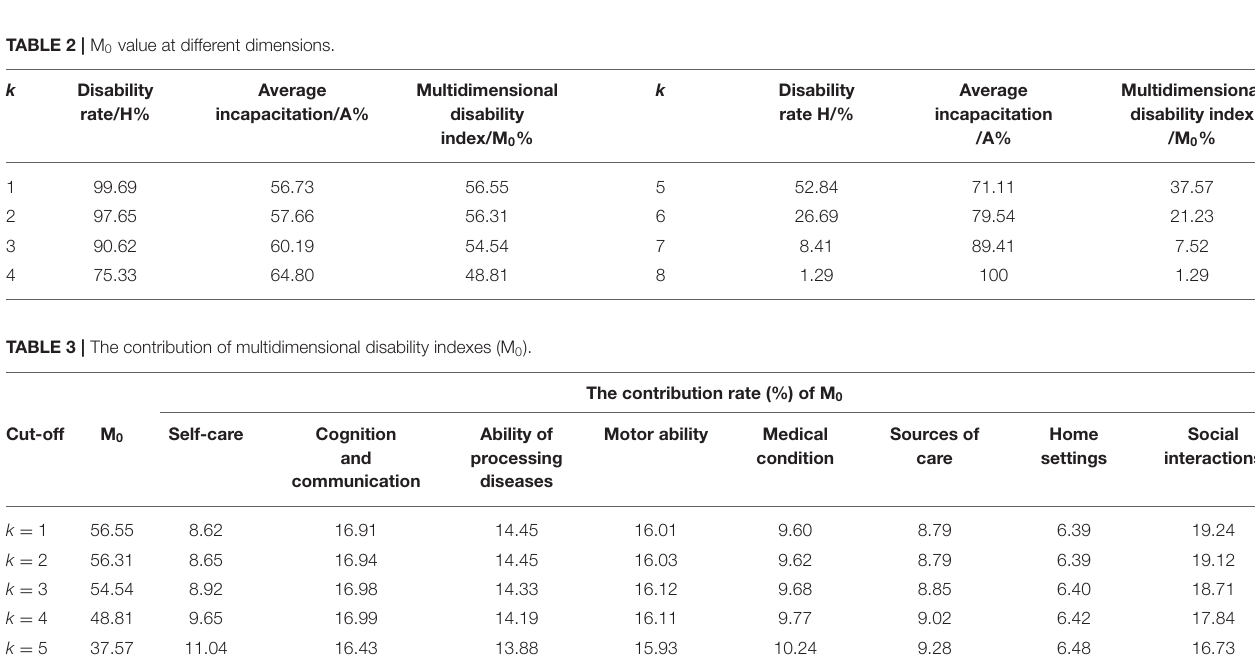
TABLE 2 | M 0 value at different dimensions.